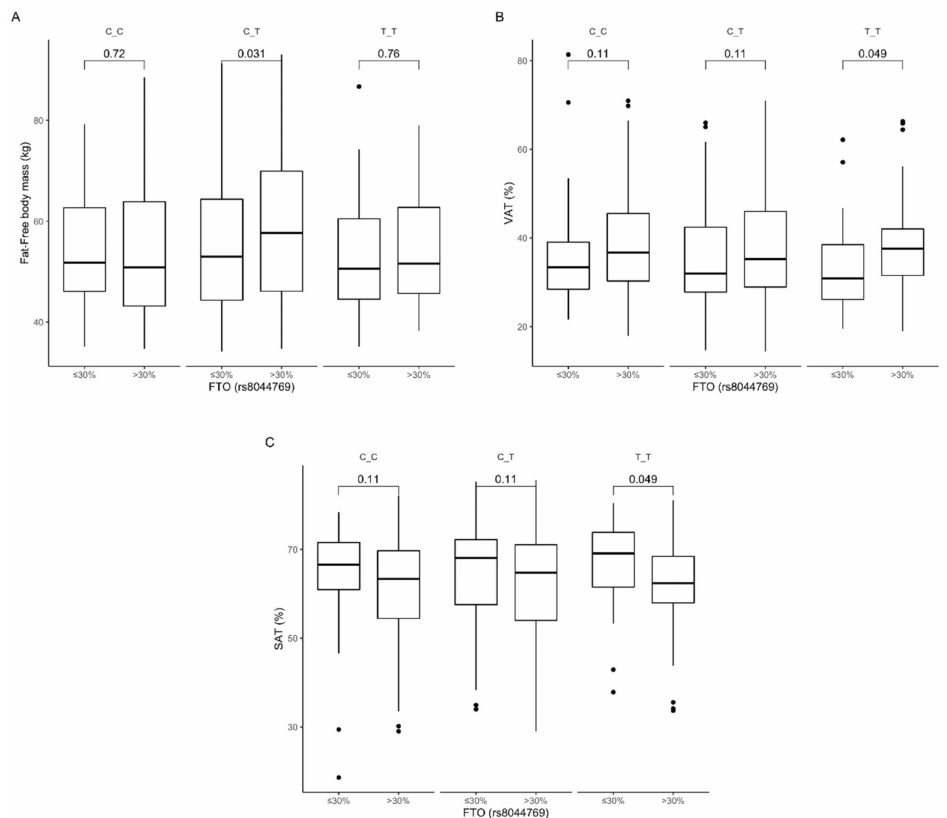
Figure 12. Association of dietary fat intake ≤ 30% and > 30% of total daily energy intake with ( A ) fat-free body mass (kg), ( B ) SAT (cm 3 ), and ( C ) VAT (%) in FTO rs8044769 genotypes